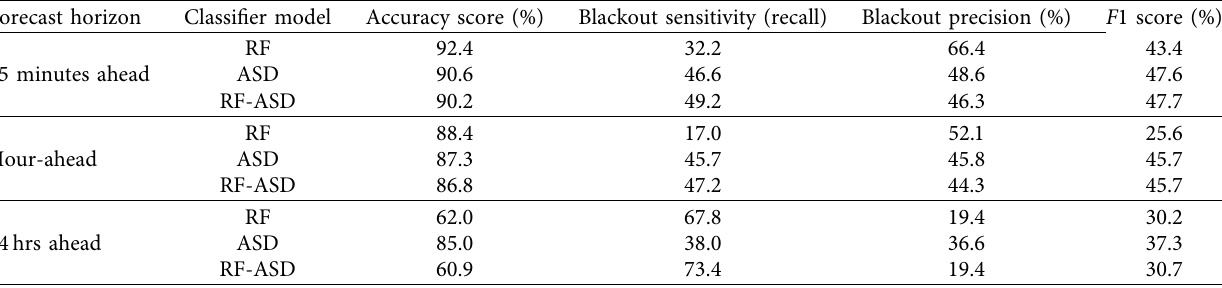
Figure 7: Power outage classification accuracy scores for 15 minutes ahead predictions. Table 2: Overall blackout forecast classification performance.